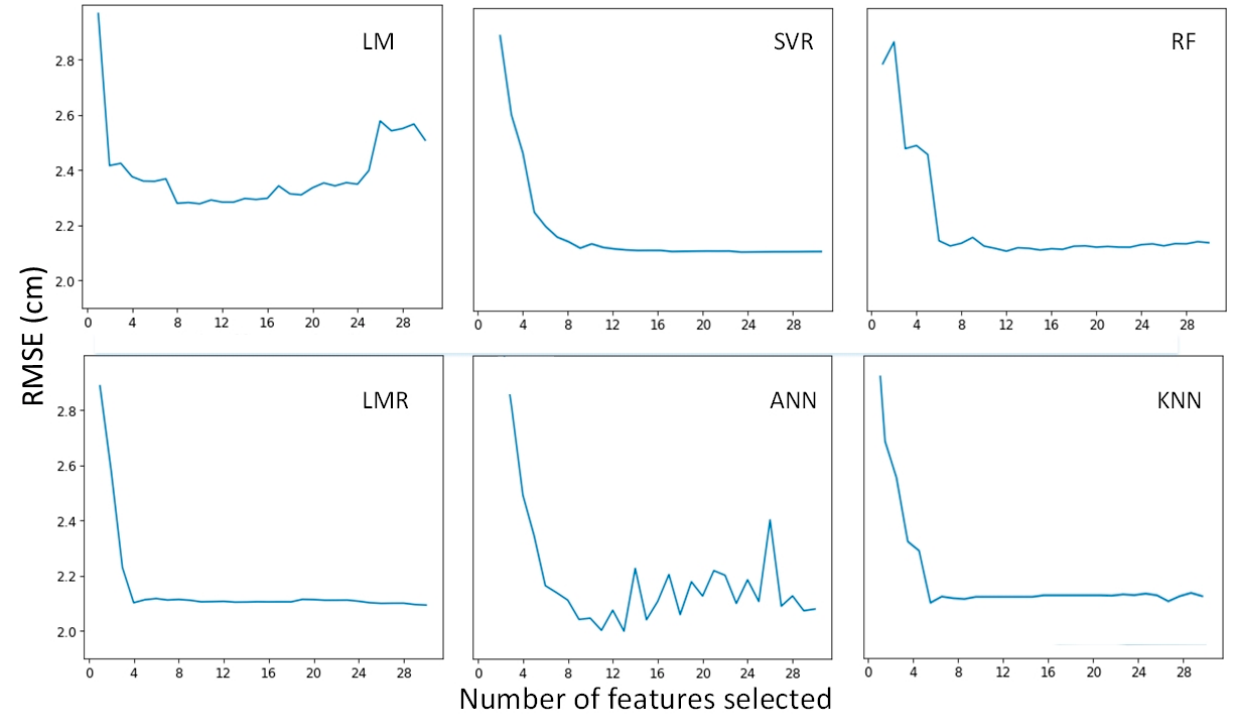
Figure 7. Impact of the number of input features on the average of cross-validated RMSE for different prediction algorithms.